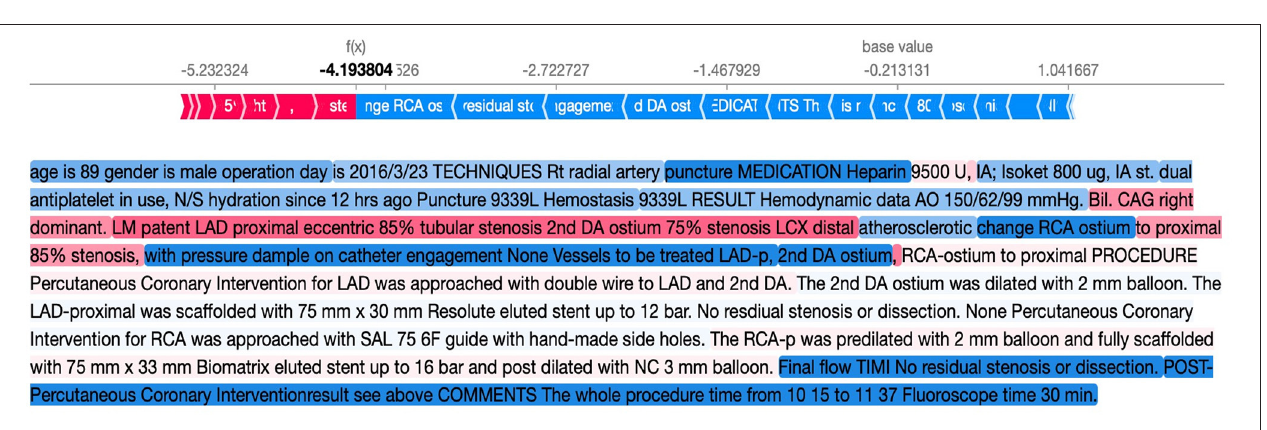
FIGURE 3 | Example of the SHAP text plot for our reports. The words in red suggest that the word helps to predict mortality, whereas the words in blue suggest prediction of survival. SHAP, SHapley Additive